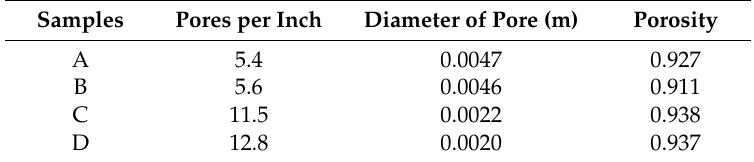
Table 4. Material properties of the porous metal foam samples for di ff erent pore per inch